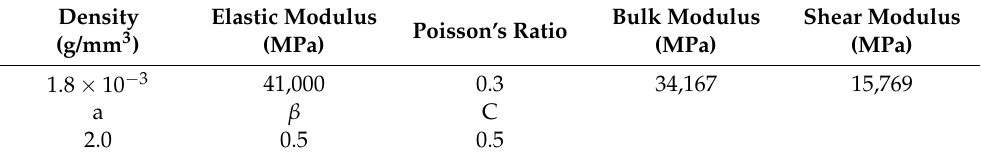
Table 2. Material properties.